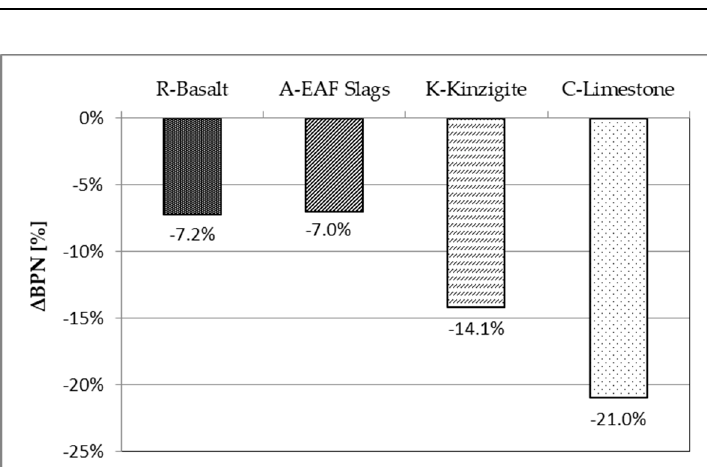
Table 6. Roughness data collected by profilometric analysis (baseline length ≈ 200 μ m).